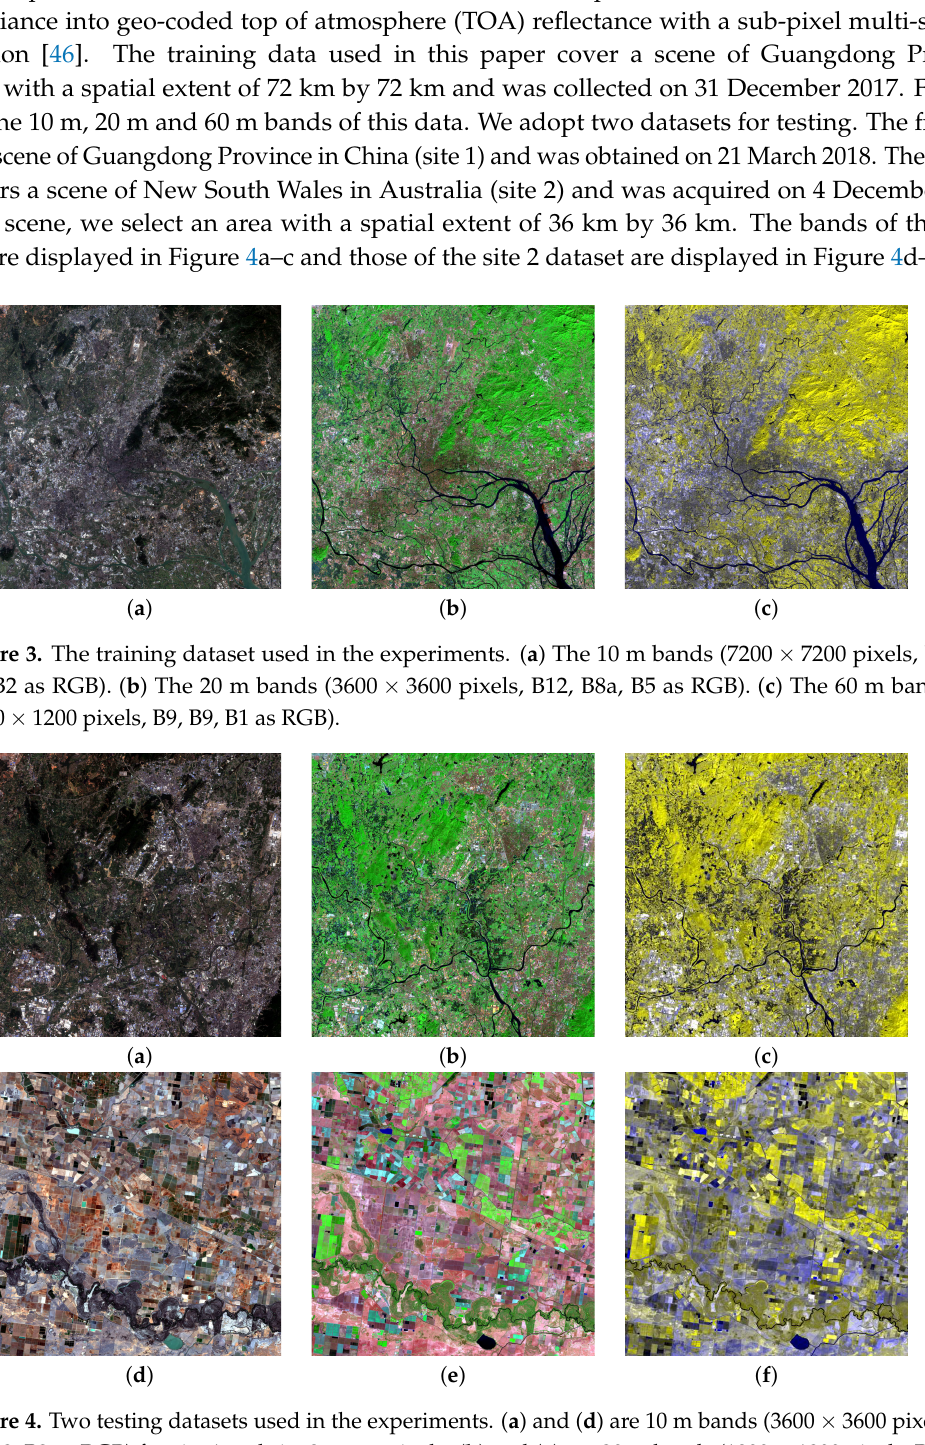
Figure 4. Two testing datasets used in the experiments. ( a ) and ( d ) are 10 m bands (3600 B4, B3, B2 as RGB) for site 1 and site 2, respectively. ( b ) and ( e ) are 20 m bands (1800 B8a, B5 as RGB) for site 1 and site 2, respectively. ( c ) and ( f ) are 60 m bands (600 as RGB) for site 1 and site 2,